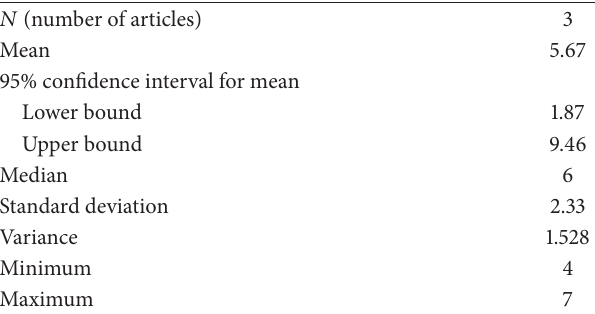
Table 7: Overall findings of strength of evidence (descriptive